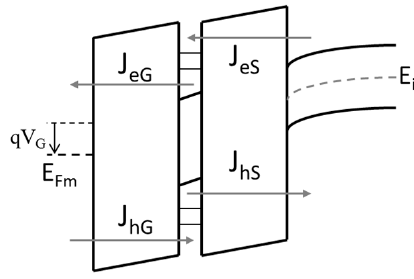
Figure 3. The schematic band diagram of the sample device.